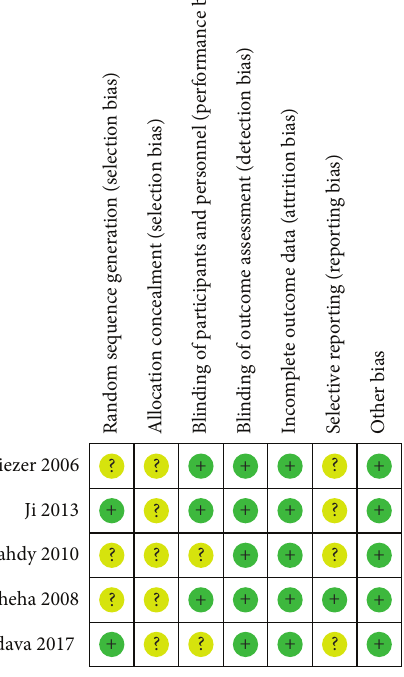
Figure 2: Methodological quality summary: authors’ judgments about each methodological quality item for each included study. Note: + represents yes; ? represents